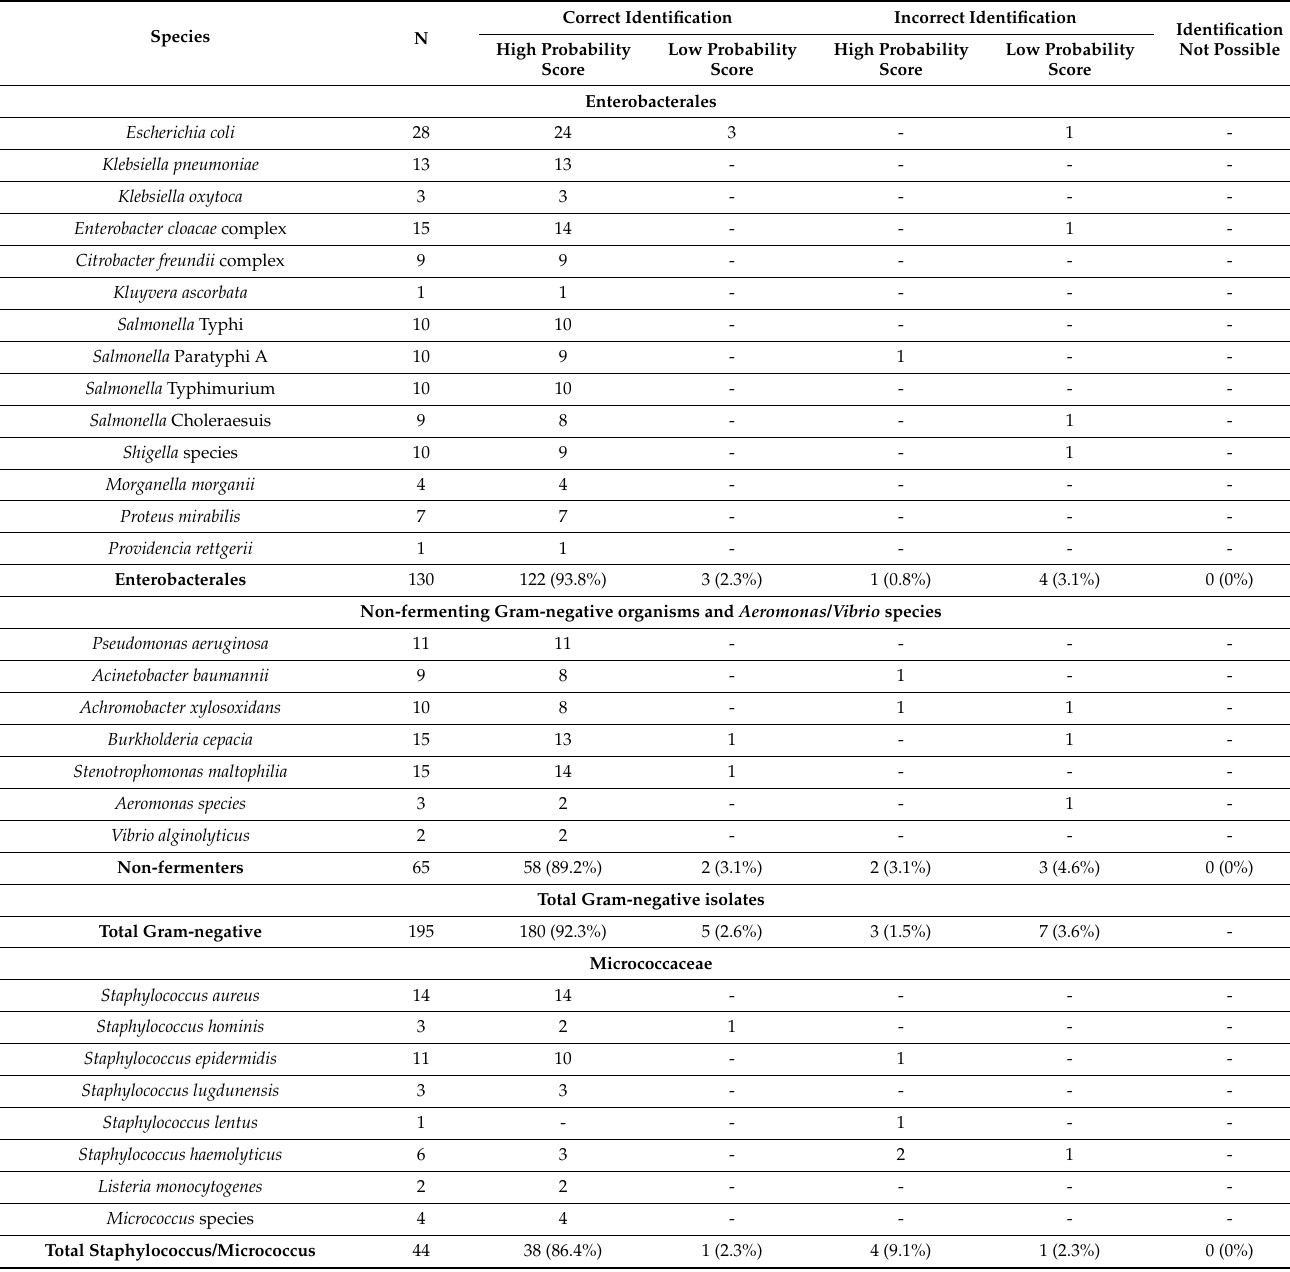
Table S2 for details per species). Reference strains were obtained from the Belgian Sciensano (Scientific Institute of Public Health) (https://www.wiv-isp.be/QML/activities/external_ quality/rapports/_nl/rapports_annee.htm; accessed 18 February 2021) as part of external quality assessment programs. The collection included 323 isolates (195 Gram-negative and 128 Gram-positive) of species represented in the MicroScan database. The remaining 44 isolates, belonging to species that were not present in the MicroScan database, were used to look for anticipated incorrect identifications. Table 2. Overall performance of the MicroScan Gram-negative, Gram-positive, and MSF ID panels for species represented in the MicroScan database. N = total number of isolates tested. Details of incorrect identifications with their probability scores are listed in Table 3. * Formerly part of Streptococcus bovis